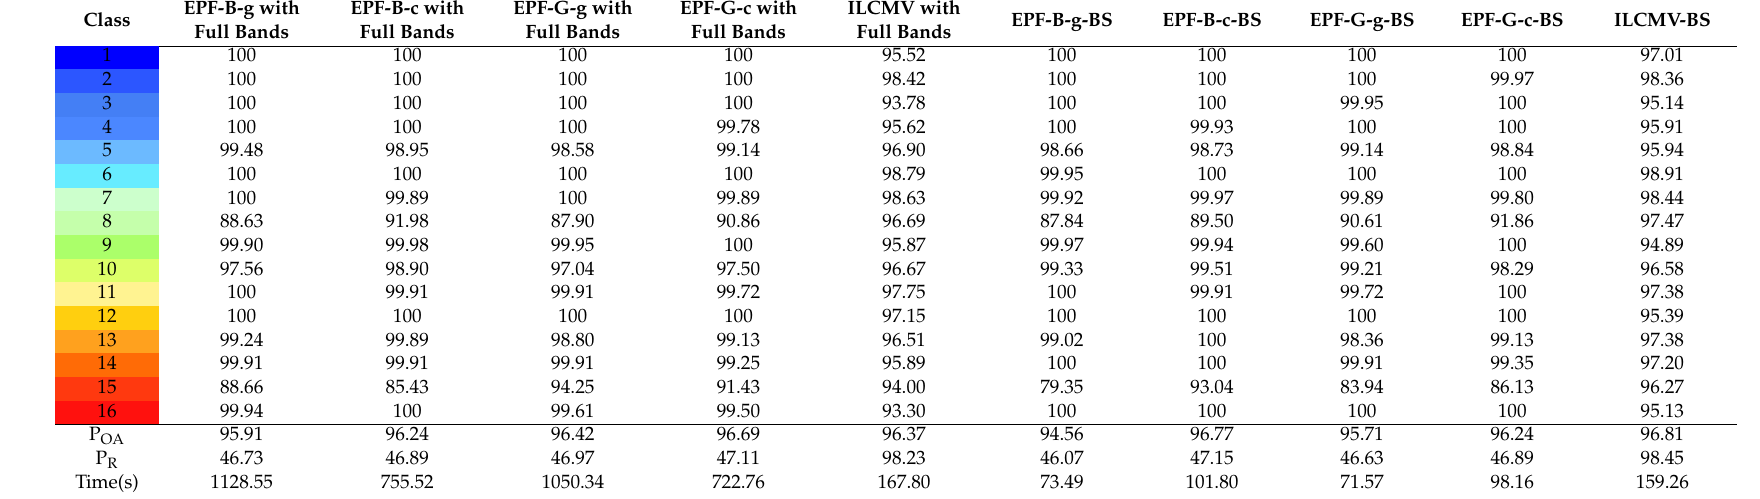
Table 11. P OA and P R calculated by the classification results using full bands and the bands selected by SQ LCMV-BSS-2 in Table 2 for Salinas.